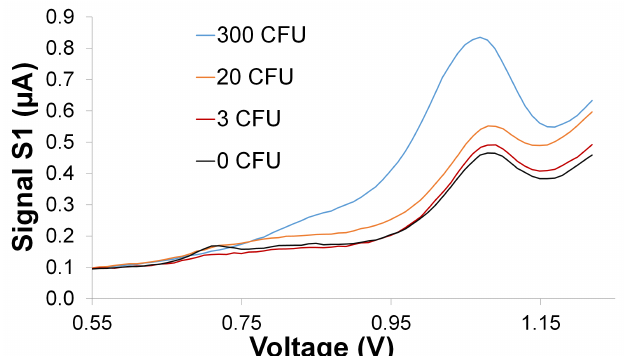
Figure 7. Absolute DPV signals (S1) corresponding to an order of magnitude change in concentration of E.coli O157:H7 from 3 to 300 CFUs. EC measurement condition: pulse size: 20 mV, scan rate: 5 mV/s, scan range 0.5 V to 1.2 V ( vs. Ag/AgCl reference electrode).